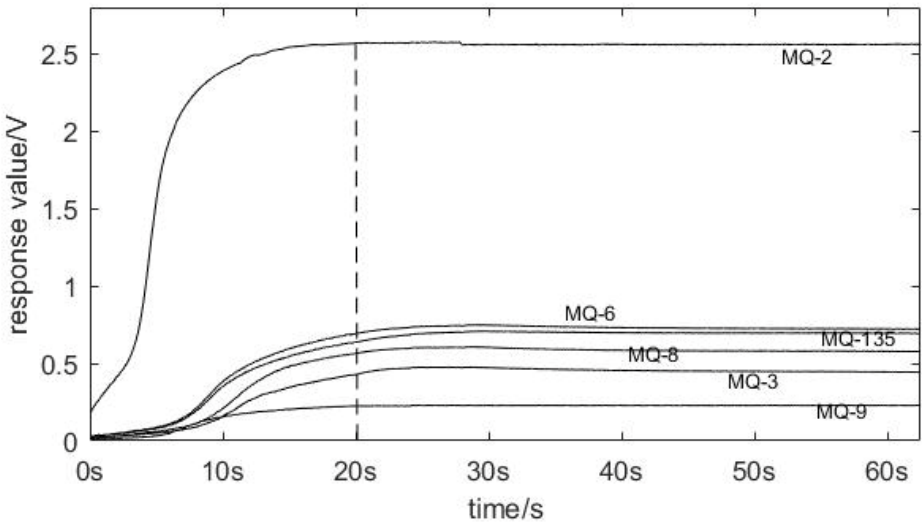
Figure 9. The sensor response values of L1 apple quality with time.